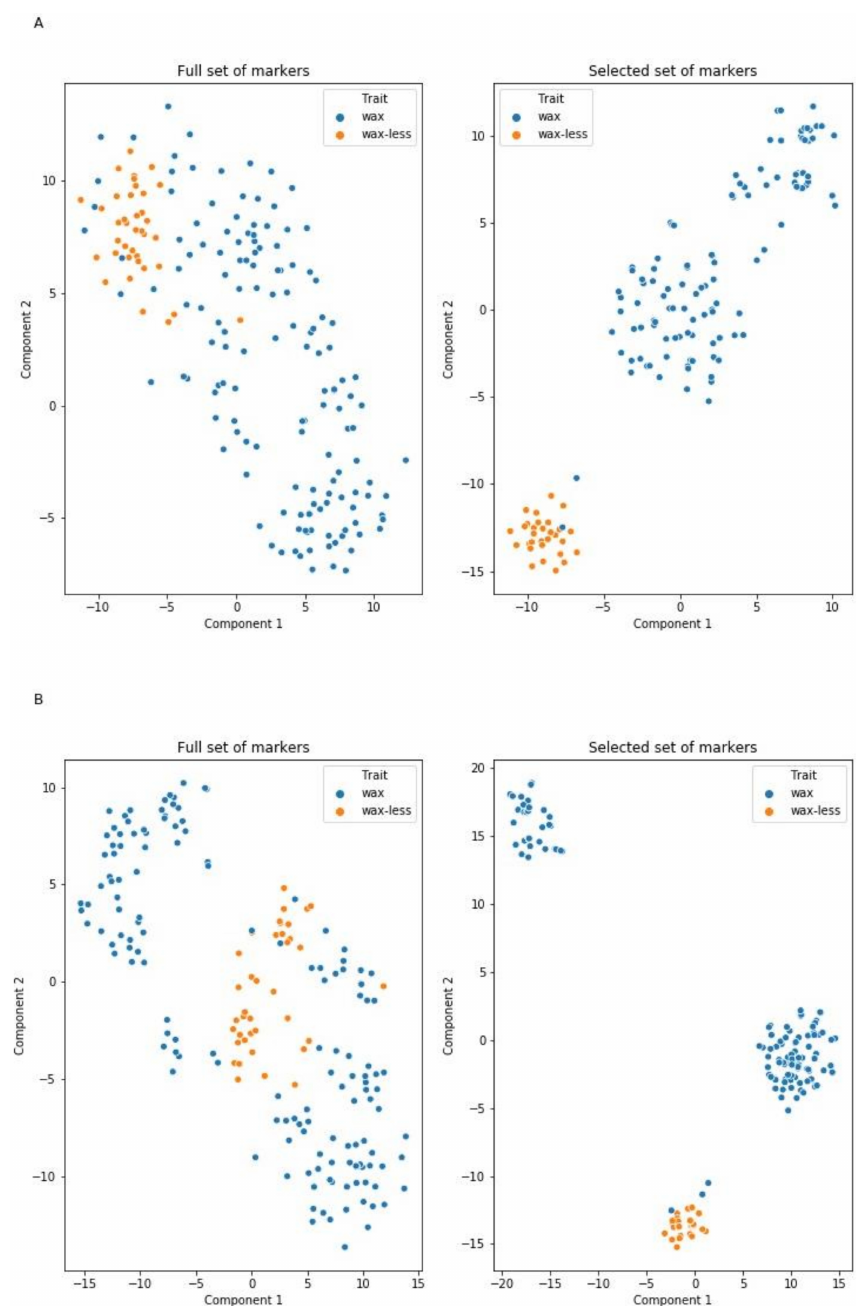
Figure 3. Projection of two classes of plants (wax and waxless) in a two-dimensional space characterized on the basis of DArTseqs assigned to chromosome 2R ( A ) and not assigned ( B ). The figures on the right show the ordering result using markers selected based on ML